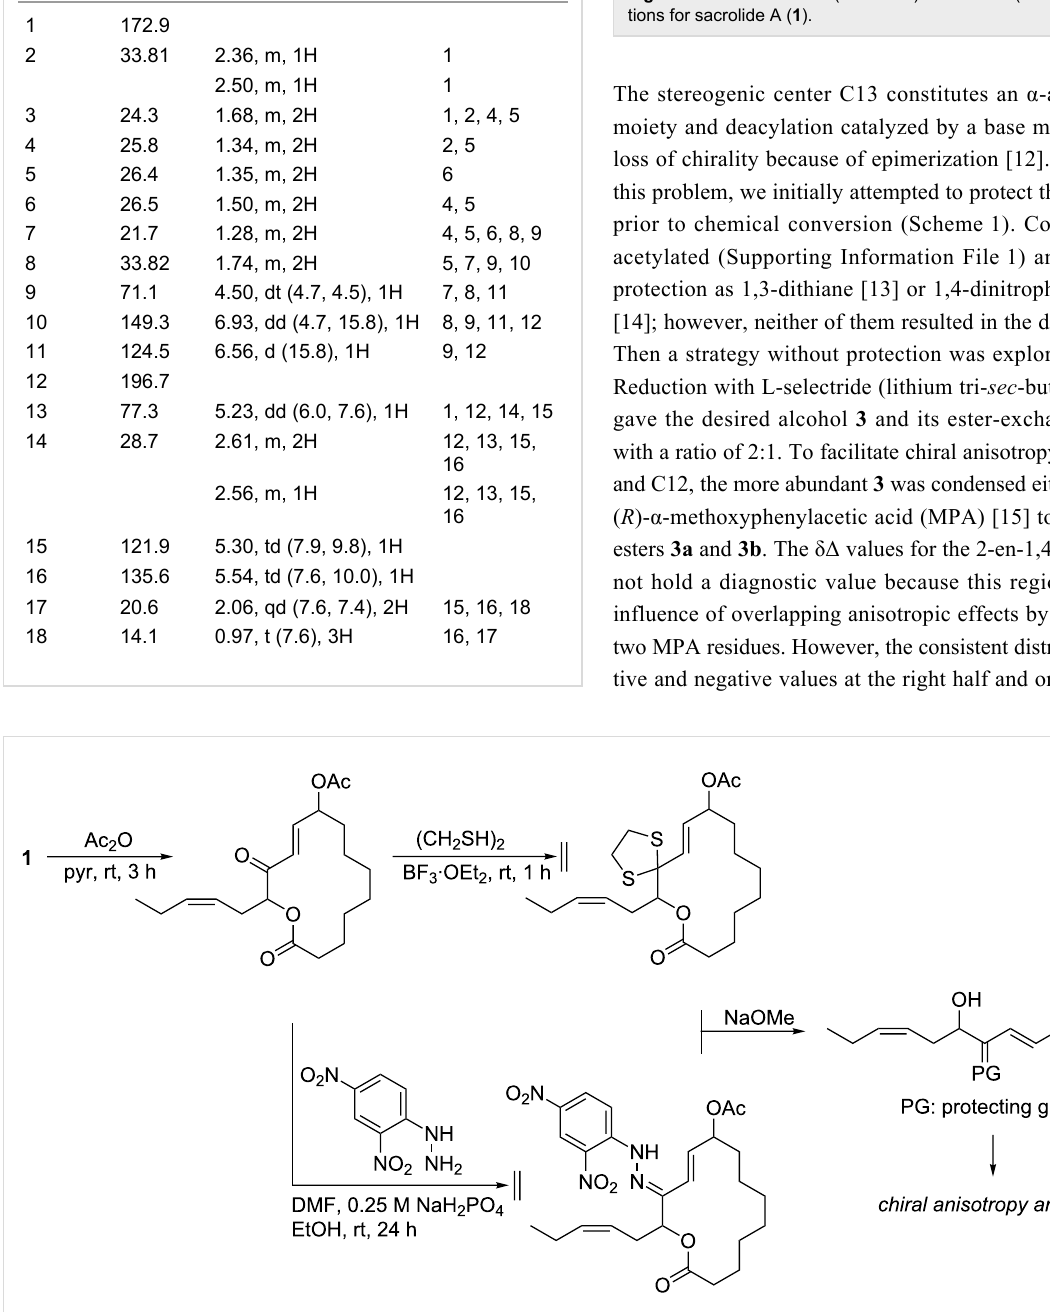
Figure 2: Selected COSY (bold lines) and HMBC (arrows) correla- tions for sacrolide A ( 1 ).